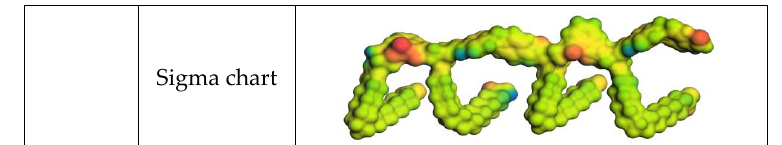
Figure 10. Three-dimensional plots of HOMO, LUMO, and σ-chart.